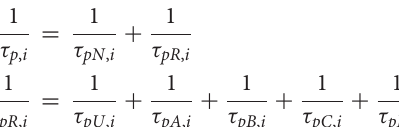
and SiGe (Chen et al., 2009; Garg et al., 2011; Yang and Minnich,